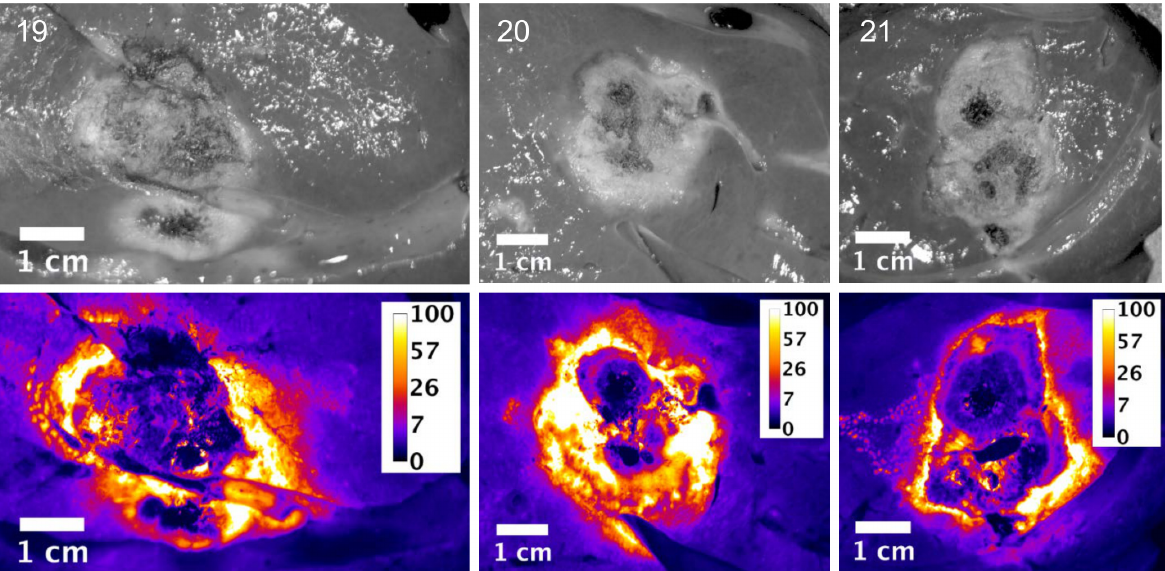
Fig 9. Plain and fluorescent images of ablation zone in pigs in Study C, group 3. Each pig received six sequential, overlapping 12 minute ablations and 3 minute cool down between ablations (total time = 90 minutes) with the Angiodynamics device. Scale is μ g/g doxorubicin.